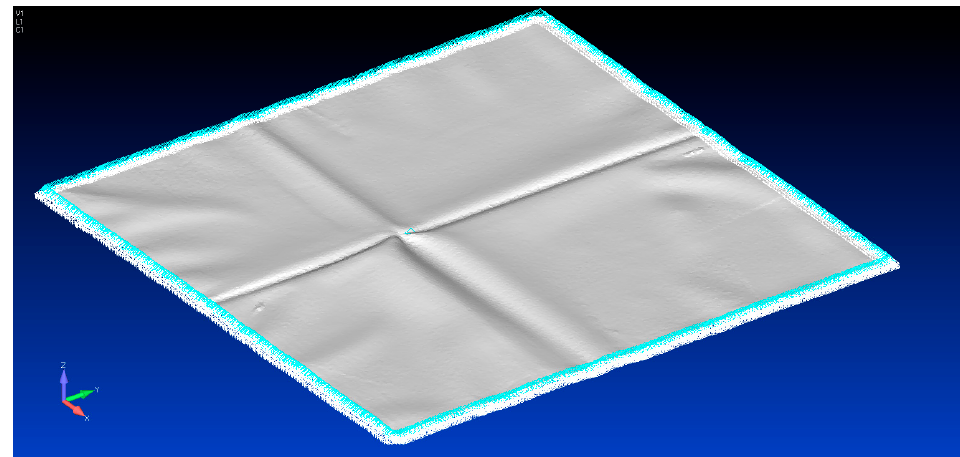
Figure 16. Imported geometry of the test membrane in its unloaded condition with edge constraints imposed.